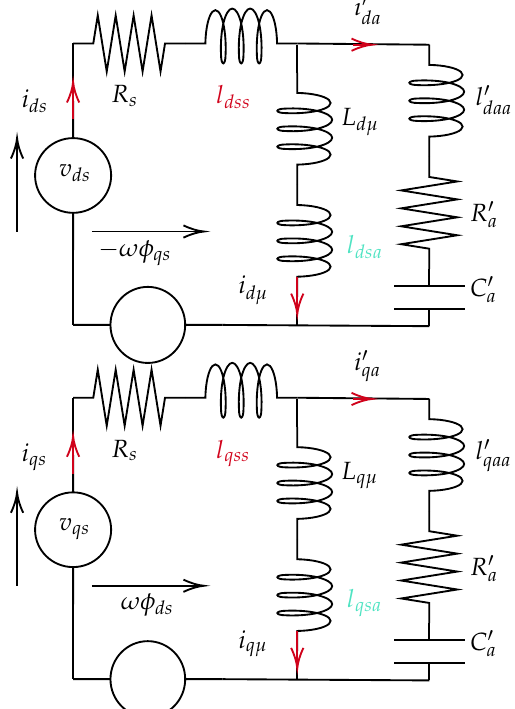
Figure 5. Equivalent electrical circuits on the primary winding side. In the d -axis ( top ). In the q -axis ( bottom ).